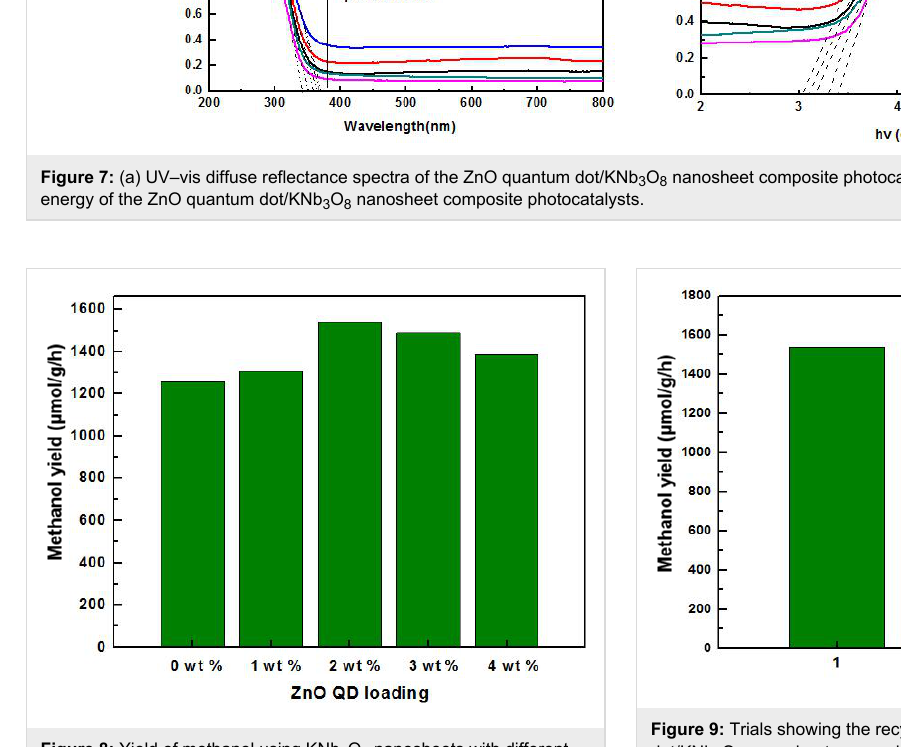
Figure 8: Yield of methanol using KNb 3 O 8 nanosheets with different amounts of ZnO quantum dot (QD) loadings: (0) pure KNb 3 O 8 ; (1) 1 wt % ZnO QDs; (2) 2 wt % ZnO QDs; (3) 3 wt % ZnO QDs; (4) 4 wt % ZnO QDs.